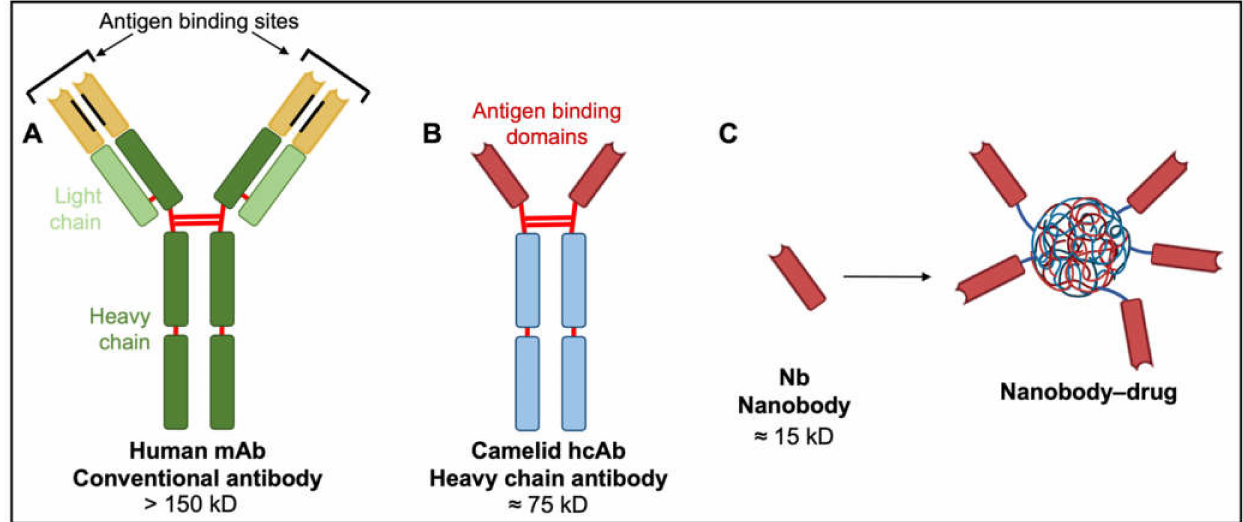
Figure 5. Comparison of human, camelid and synthetic nanobody structures. ( A ) Conventional antibodies have two heavy and two light chains each comprising non-covalently associated variable domains (VH and VL) with unique antigen binding sites. The orientation of these variable domains is mediated by a hydrophobic interface (black lines) and further stabilized by the disulfide-linked CL and CH1 domains (red lines). ( B ) Camelid heavy chain antibodies consist of two heavy chains lacking CH1 domains and containing target-binding modules composed of one variable domain (VHH). ( C ) An isolated VHH region termed a nanobody (Nb) is entirely hydrophilic. Nanoparticles made of liposomes containing anti-neoplastic drugs linked to nanobodies have exciting potential as tumor-targeting drug